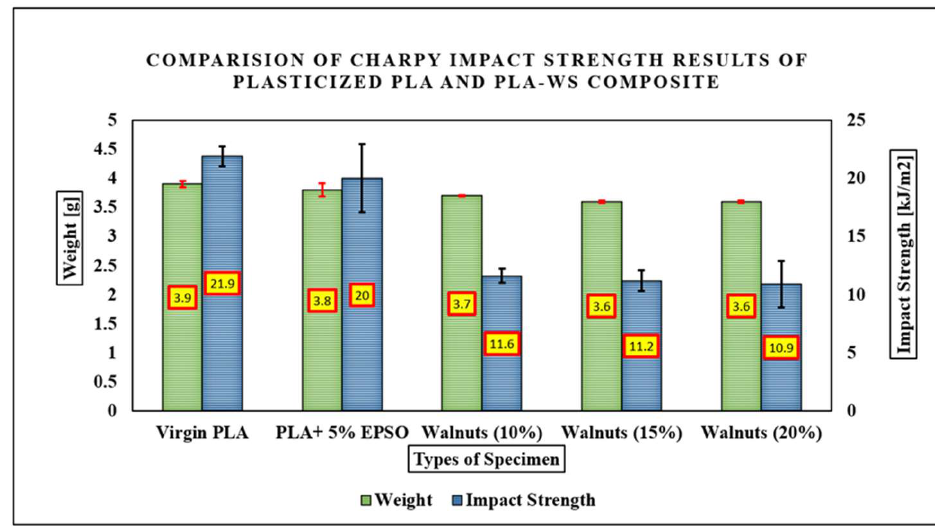
Figure 11. Charpy impact test result—Impact strength [kJ/m 2 ] comparison.